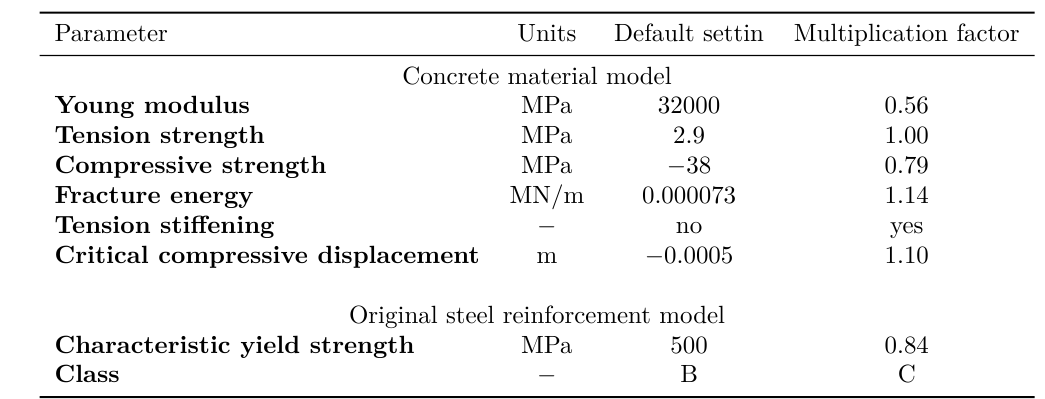
Table 1. Quality and Operations Assessment Schedules [7].